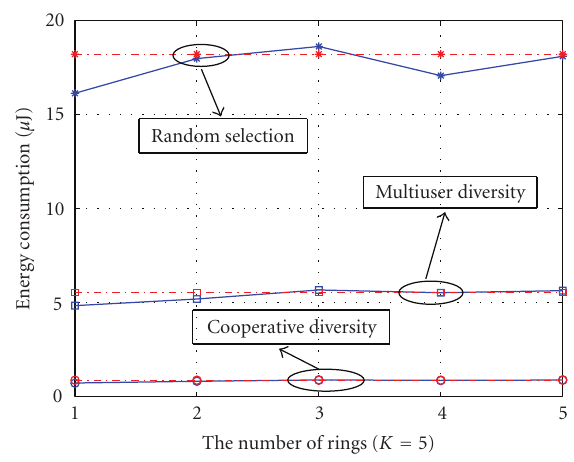
Figure 8: Energy balancing across